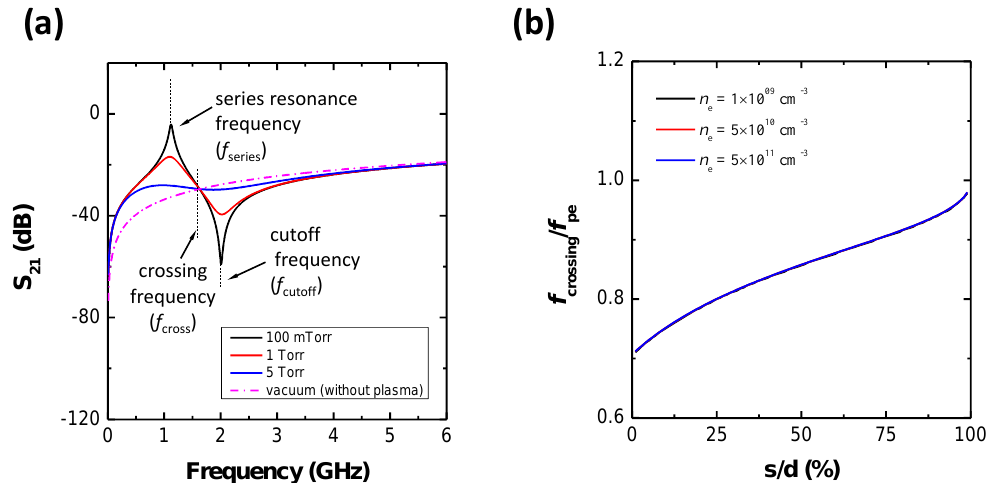
Figure 5. ( a ) S 21 spectra at 100 mTorr, 1 Torr, 5 Torr, 10 Torr, and vacuum (without plasma) with an electron density of 5.0 × 10 10 cm − 3 and a fixed sheath width of 0.234 mm. ( b ) Normalized crossing frequency ( f crossing / f pe ) over the sheath width portion with antenna distance ( s / d ), where s and d are the sheath width and the antenna distance,